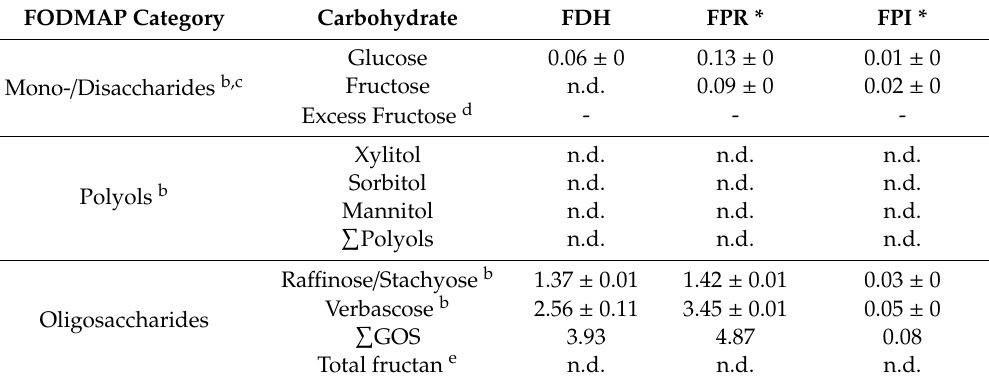
Table 7. FODMAP content of faba bean